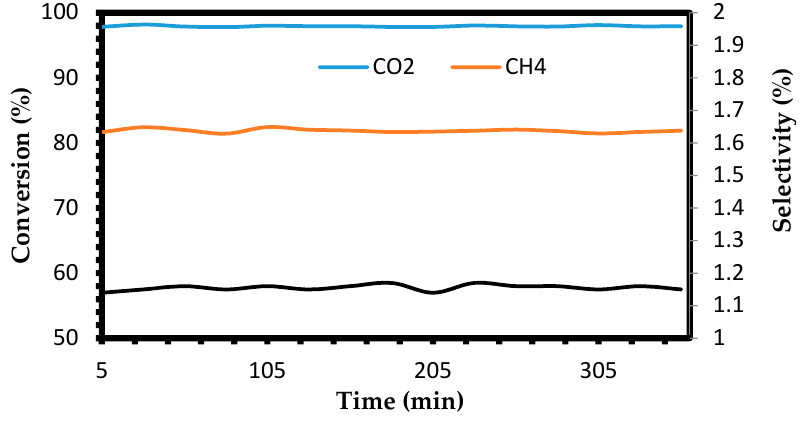
Figure 11. Stability tests of the Pt,Pd,Ni / Mg 0.85 La 3 + 0.15 O catalysts at 900 ◦ C for the 1:1 ratio of CH 4 :CO 2